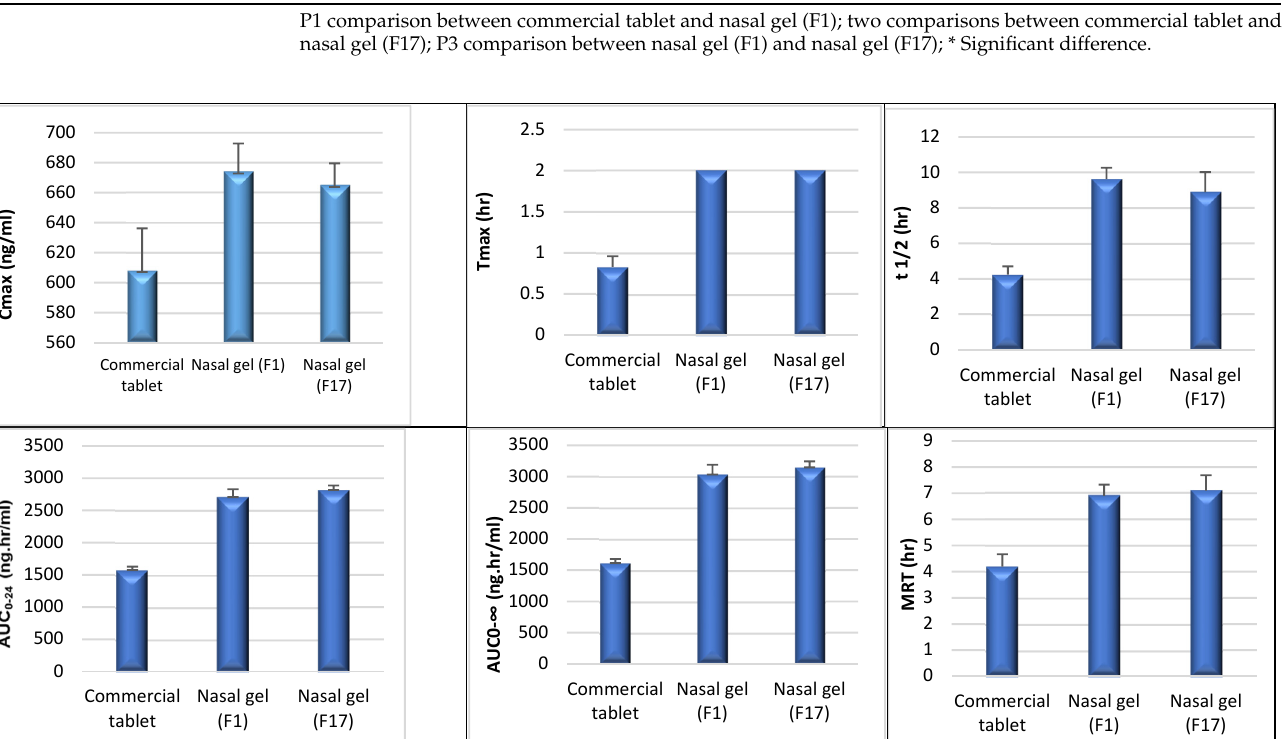
Figure 2. A comparison of the pharmacokinetic parameters (Cmax, T max , t 1/2 , AUC 0–24 , AUC 0–inf , MRT ) between the three studied groups (commercial tablet, F1, and F17) using a post hoc test. Relative bioavailability was calculated as a percentage value as follows [22,23]: Relative bioavailability (%) = (AUC 0–24 test /AUC 0–24 reference) × 100, (1) The relative bioavailability of the tested ITO HCl in situ nasal gel (F1) to the commercial tablet based on the mean AUC 0–24 was found to be 171.85%, and for (F17) to the commercial tablet was 178.90%. This can be seen in Figure 3.